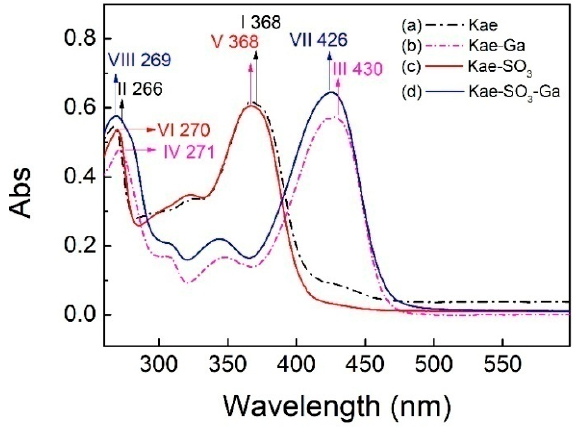
Figure 2. Ultraviolet-visible (UV-Vis) spectra of ( a ) Kae, ( b ) Kae-Ga, ( c ) Kae-SO 3 and ( d ) Kae-SO 3 -Ga, respectively. Table 3. Ultraviolet-visible (UV-Vis) spectra data of Kae, Kae-Ga, Kae-SO 3 and Kae-SO 3 -Ga, respectively.